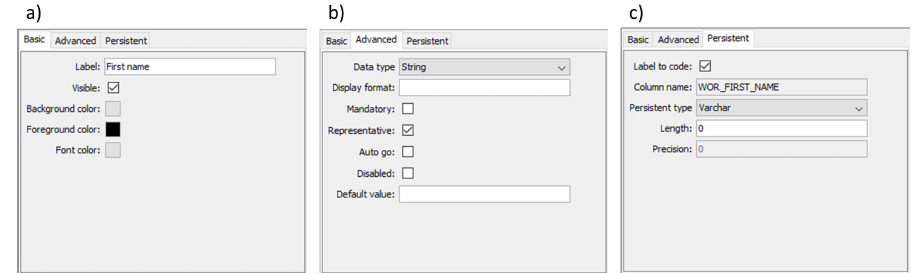
Figure 2. An example of ( a ) basic, ( b ) advanced, and ( c ) persistence settings for an Editable